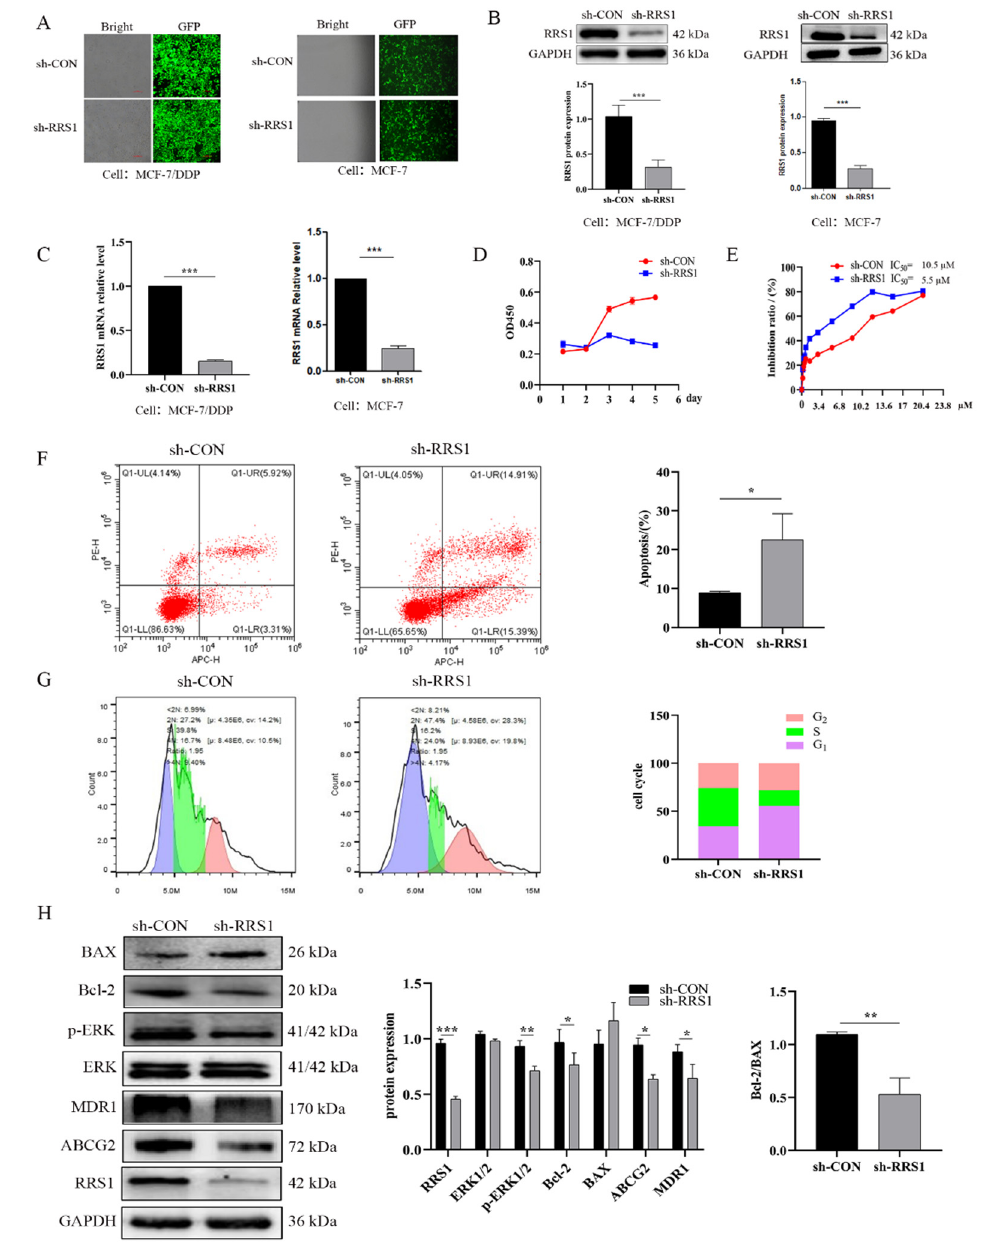
Figure 2. RRS1 knockdown reduced the proliferative rates of MCF-7/DDP cells and sensitized them to cisplatin. ( A ) MCF-7/DDP and MCF-7 cells were infected with lentiviruses, and transduction effi- ciency after 72 h was determined in terms of GFP fluorescence. Scale bars = 100 µ m. ( B ) Immunoblot showing RRS1 protein levels in the MCF-7/DDP and MCF-7 cells infected with the RRS1-shRNA or scrambled shRNA lentiviruses. ( C ) RRS1 mRNA levels in the MCF-7/DDP and MCF-7 cells treated. ( D ) Proliferation rates of sh-CON and sh-RRS1 MCF-7/DDP cells. ( E ) IC 50 of DDP for control and RRS1-knockdown MCF-7/DDP cells. ( F ) Flow cytometry plots showing apoptosis rates in the indicated cells. ( G ) Cell cycle distribution of the indicated cells. Purple bars, percentage of cells in G1 phase; green bars, percentage of cells in S phase; pink bars, percentage of cells in G2 phase. Data are the means of three experiments. ( H ) Immunoblots showing the expression levels of the indicated proteins in the sh-CON and sh-RRS1 groups’ cells. Data are the means ± SDs of at least three inde- pendent experiments. * p < 0.05, ** p < 0.01, *** p < 0.001. RRS1, human regulator of ribosome synthe- sis 1; DDP, cisplatin; GFP, green fl uorescent protein.